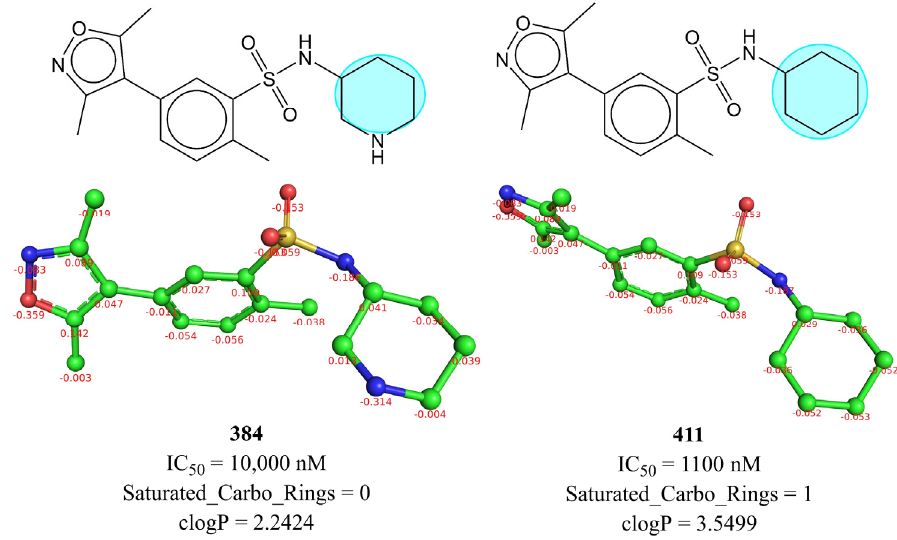
Figure 6. Depiction of influence of Saturated_Carbo_Rings on IC 50 using molecule 384 and 411 as representative examples (2D and 3D representations with partial charges).